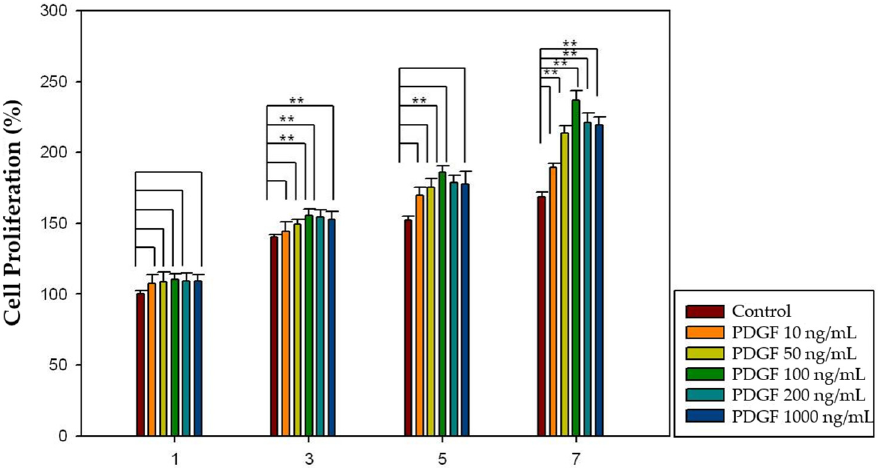
Figure 13. The effect of PDGF-BB released from HA-collagen hydrogel on pulp cell proliferation. The 50, 100, 200 and 500 ng/mL concentrations showed significantly increased pulp cell proliferation rates in the 3-, 5-, and 7-day groups ( p < 0.05). The 100 ng/mL concentration showed significantly increased pulp cell proliferation rates in all four groups ( p < 0.05). The results are expressed as mean values ± standard deviation. ** indicates the statistically significant differences ( p < 0.05). PDGF, platelet-derived growth factor.